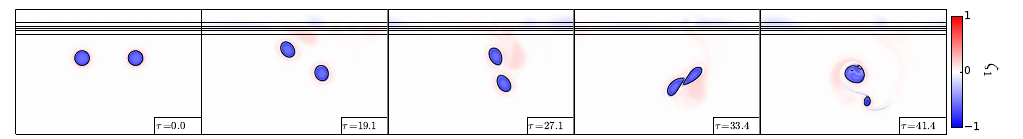
Figure 17. Merger of two anticyclones initially separated by d = 7.2 R for γ − 3, d c / R = 4.0; time series of the upper layer relative vorticity (Equation (3)).